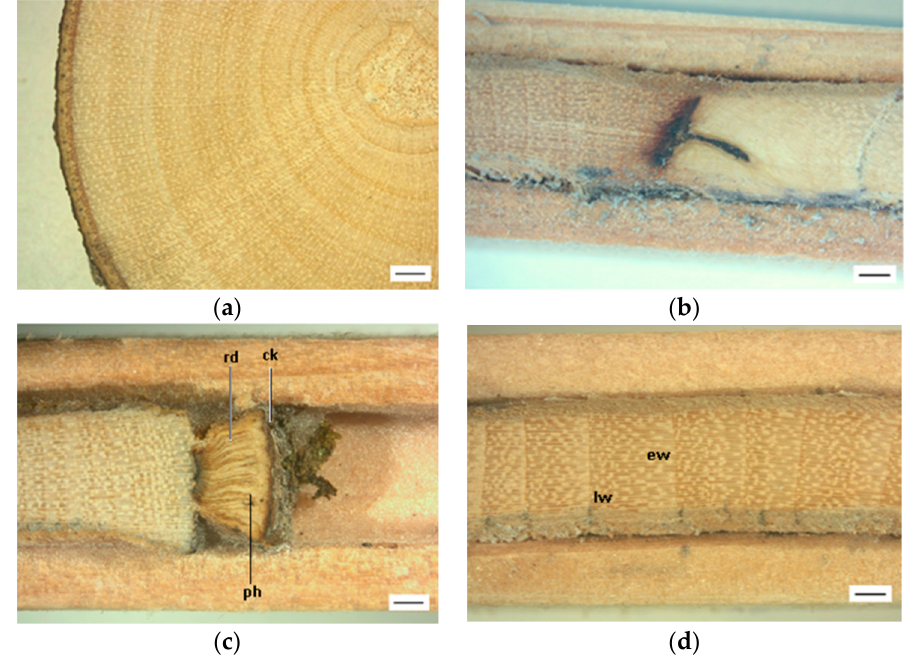
Figure 2. Macroscopic view of L. azorica (Seub.) Francostem disc ( A ) and of increment cores ( B , C , D ) taken in São Miguel Island. ( A ) Pith, distinct tree rings with latewood (lw) and earlywood (ew), and bark. ( B ) Example of some of the anomalies found in increment cores. ( C ) Younger tree rings close to cambium, phloem (lighter, ph), ray dispersion (darker, rd) and cork (ck). ( D ) Tree rings with distinct ring boundaries, and di ff erent coloration of early (ew) and latewood (lw), with vessels equally distributed along the ring. Scale bar 1